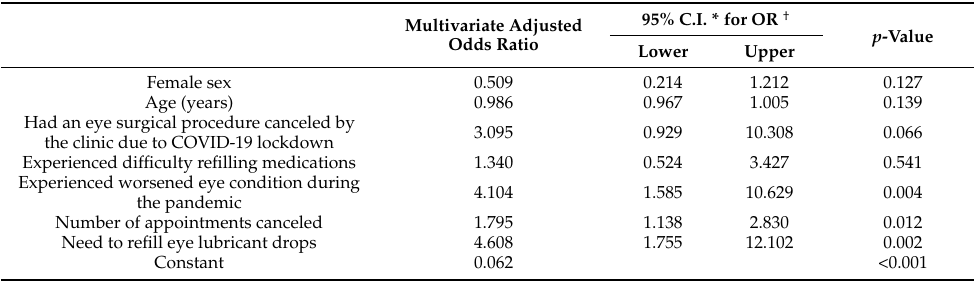
Table 5. Multivariate logistic binary regression analysis of the patients’ odds of resorting to other (external) clinical services due to appointment cancellations associated with the pandemic lockdown. Multivariate Adjusted Odds Ratio